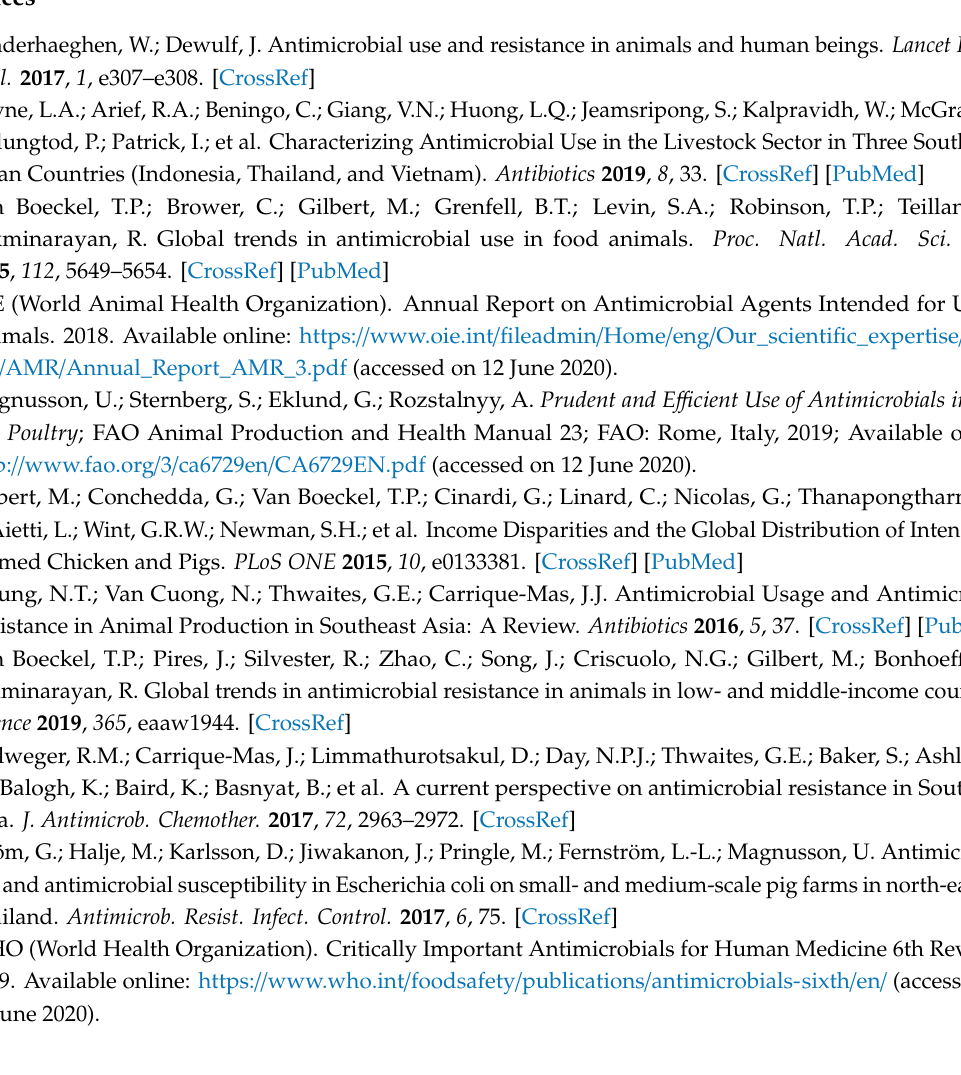
Figure S1: Susceptibility Heat map; Figure S2: Antibiogram; Table S1: Susceptibility